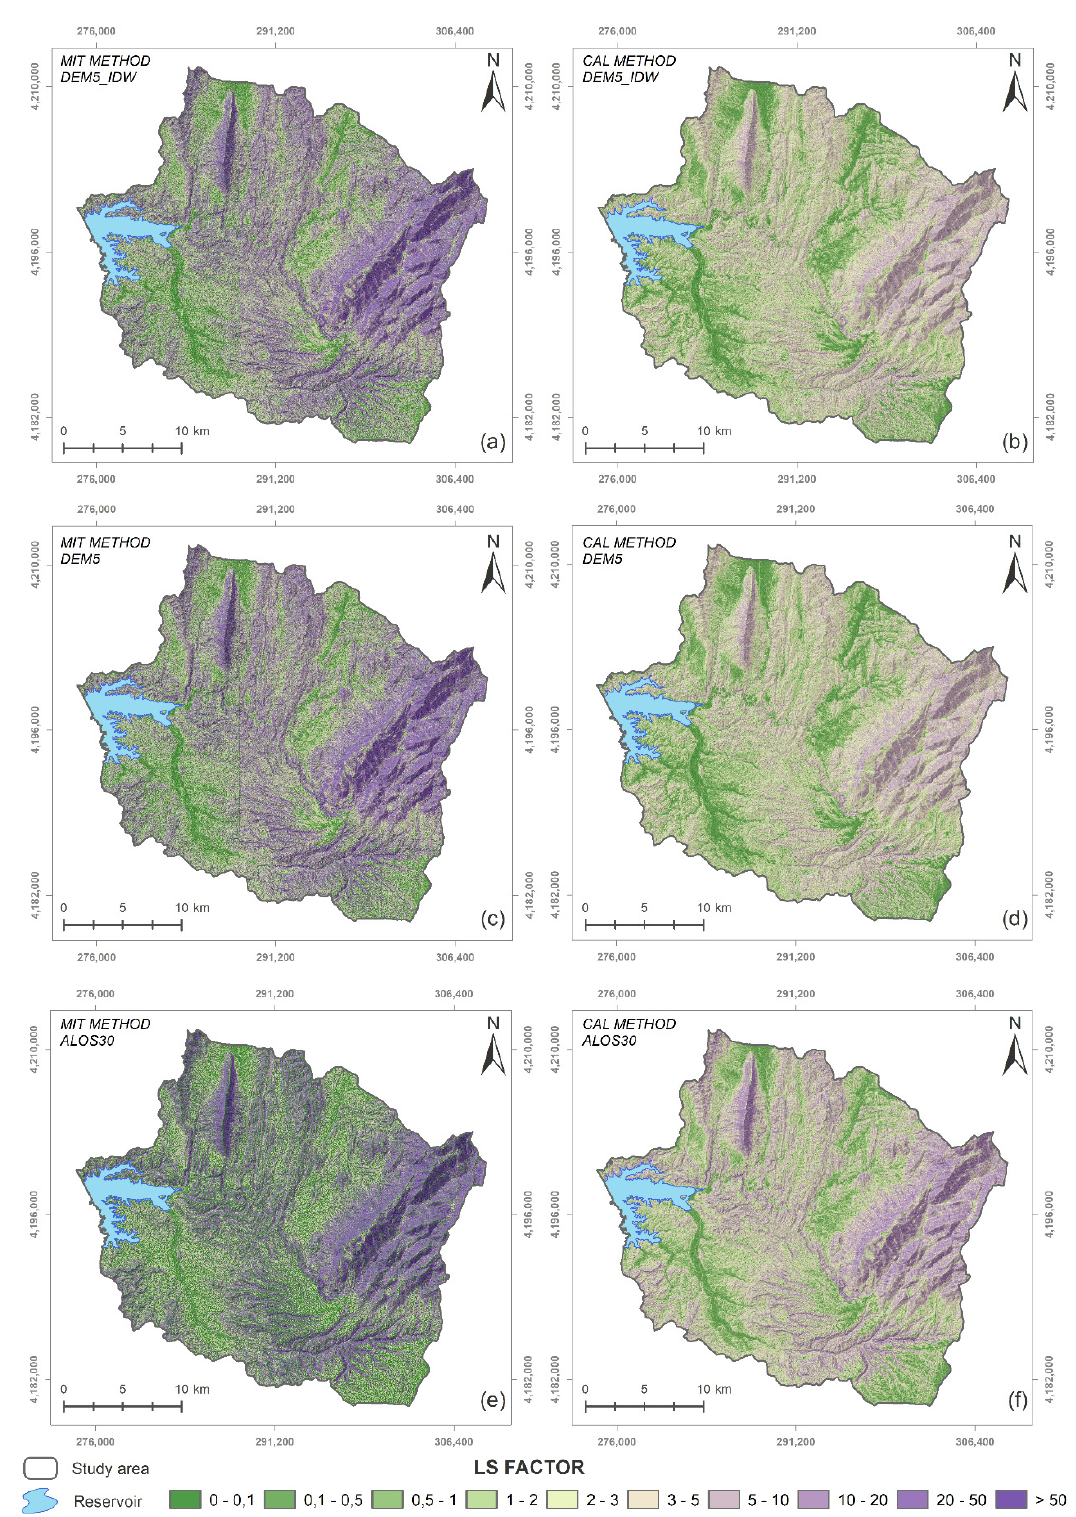
Figure A4. Maps of LS factor calculated with the MIT method applied on DEM5_IDW ( a ), DEM5 ( c ), and ALOS30 ( e ) as well as the CAL method based on DEM5_IDW ( b ), DEM5 ( d ), and ALOS30 ( f ).